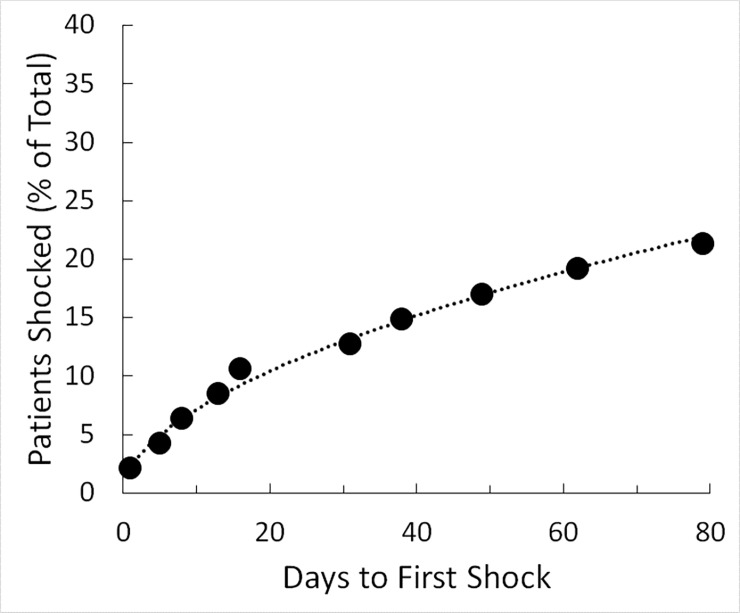
Days to appropriate shock.Days of WCD wear (x-axis) are plotted against the percentage of CS patients who had received an appropriate shock in response to VT or VF.